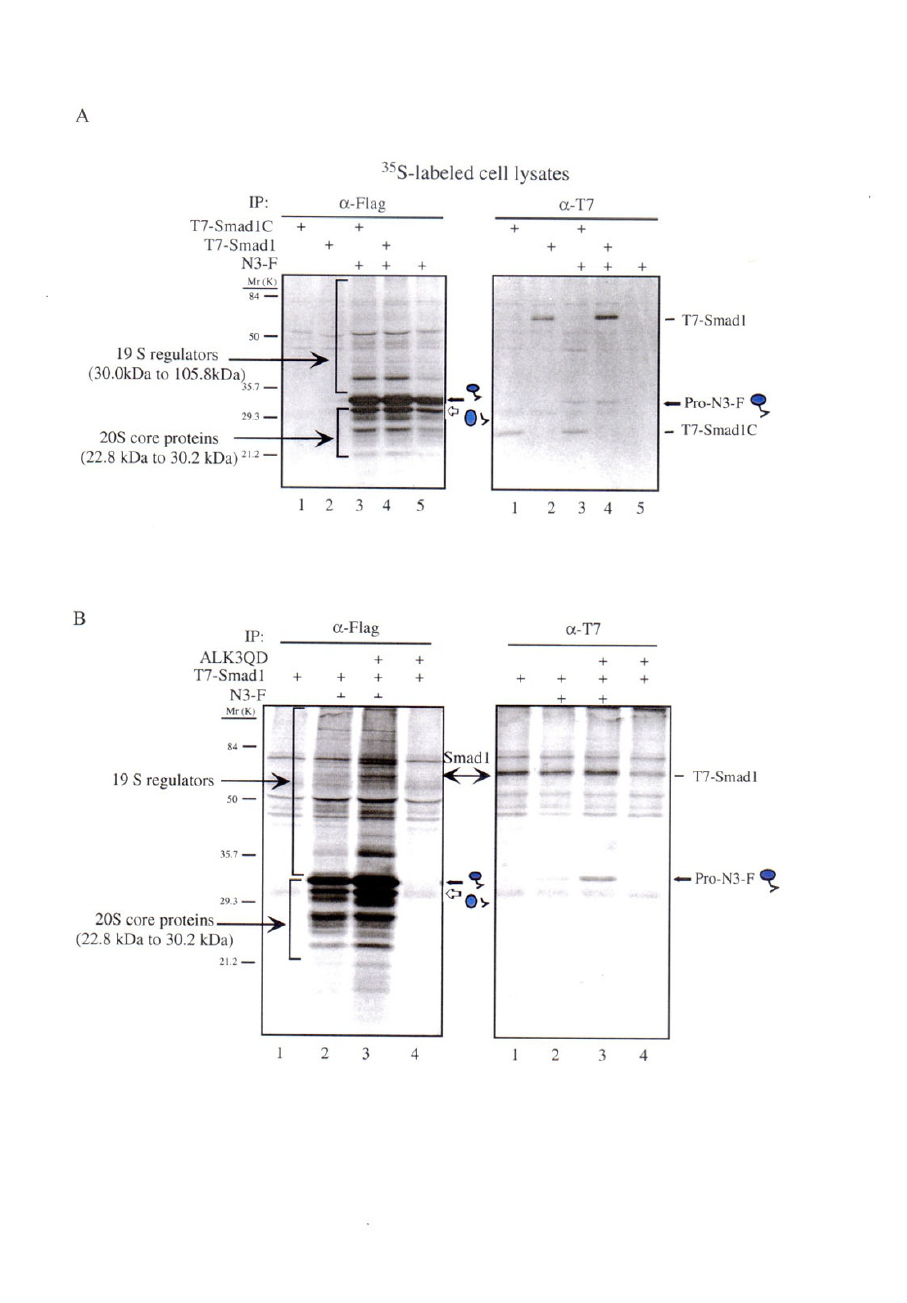
Figure 3 Smad1 interacts with the pre-assembled HsN3 and BMP type I receptor activation enhances the interaction.A. The prosequence-containing form (pre-assembled form) of HsN3 interacts with Smad1 or the MH2 domain of Smad1 (Smad1C) in COS cells upon co-expression. COS cells were transiently transfected with the indicated plasmids and metaboli- cally labeled with 35 S-methionine for the last 4 hrs. Cell lysates were immunoprecipitated with either anti-Flag to detect HsN3 (left panel) or with anti-T7 to detect Smad1 and Smad1C (right panel). The co-precipitated prosequence-containing HsN3 in both panels is marked by a filled arrow and labeled as "Pro-N3-F" and a cartoon symbol shown in Fig. 2A. The mature HsN3 is marked by an open arrow and labeled by a cartoon symbol with the cleaved prosequence next to the mature HsN3. B. The activation of BMP type I receptor ALK3 enhances the interaction between Smad1 and the pre-assembled HsN3. Methods are same as in Fig.